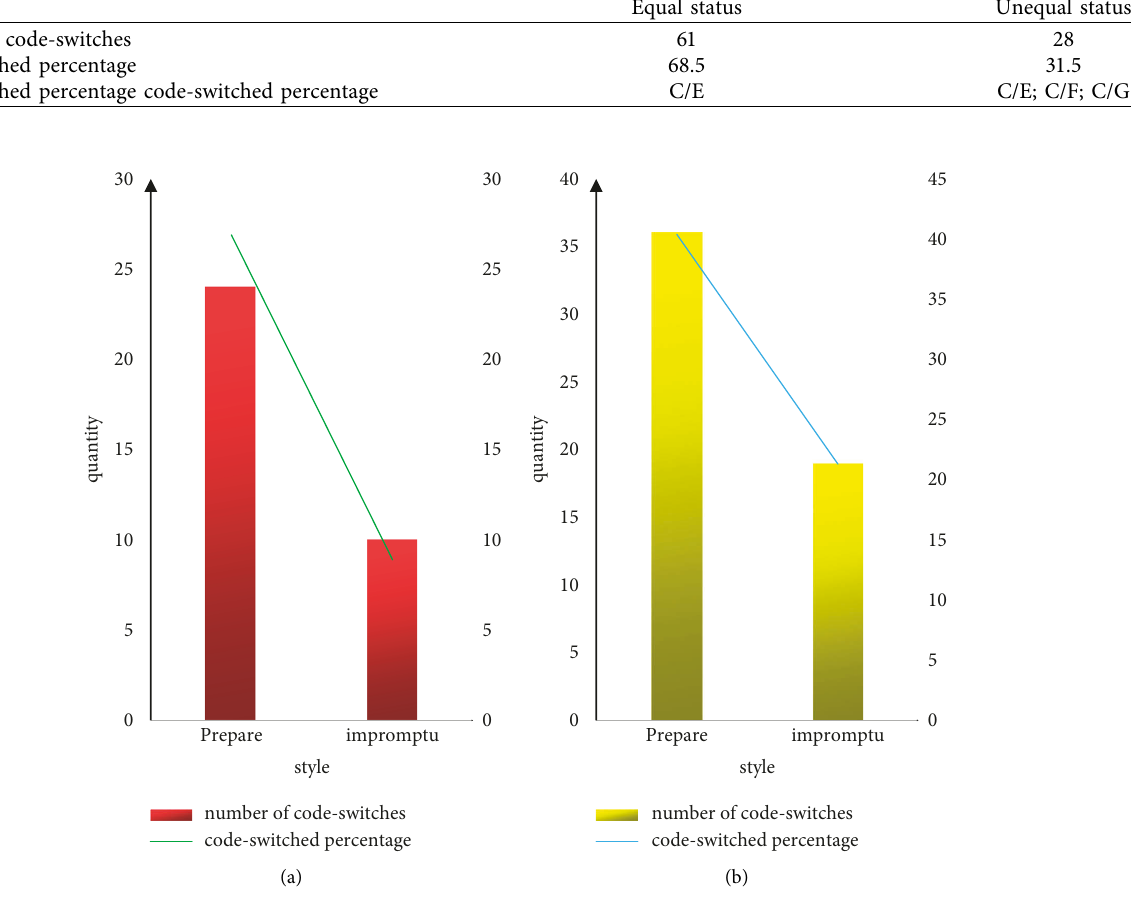
Figure 10: Distribution of code-switching in different modes. (a) Written language. (b) Spoken